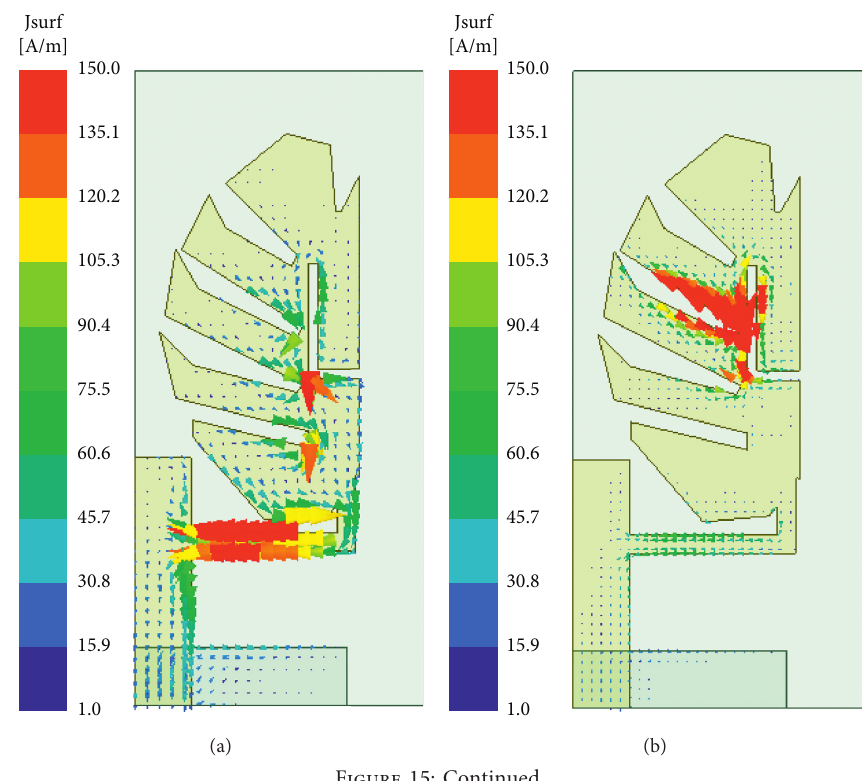
) (b) 5.4GHZ (TM 110 010